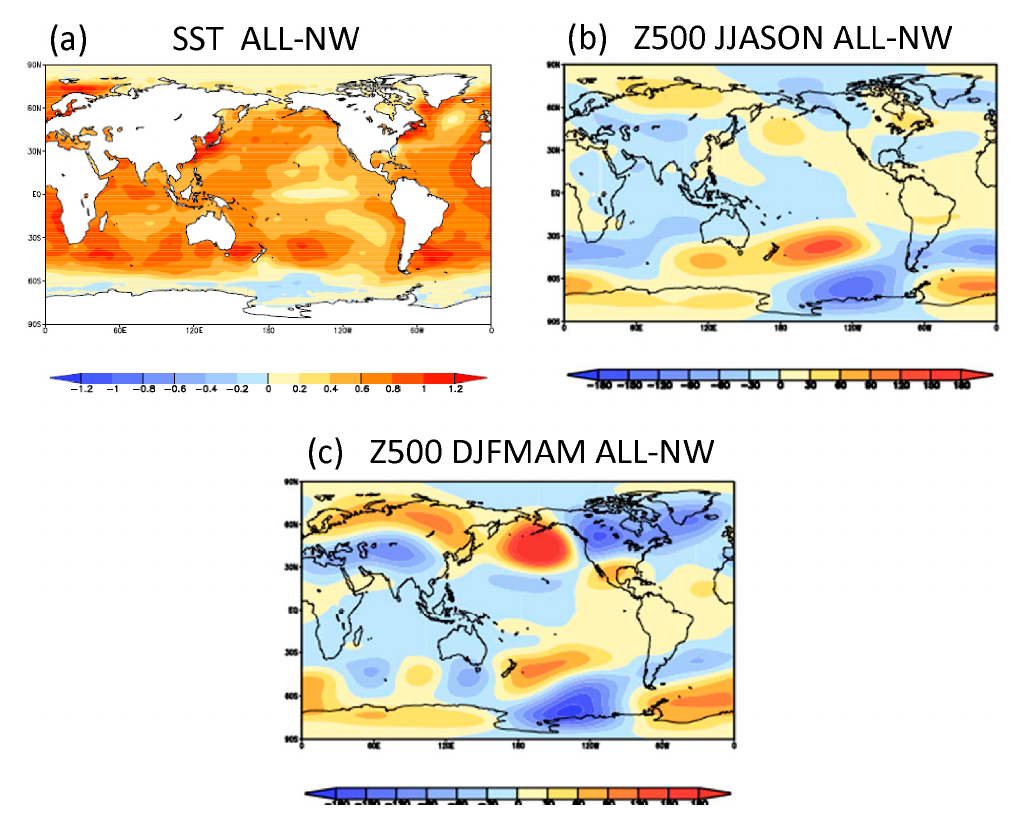
Figure 8. Differences between the ALL and NW run averaged from 1981 to 2010 (ALL minus NW). ( a ) Annual SST (K); ( b ) Z500 [m] for JJASON; ( c ) Z500 (m) for DJFMAM. A 100-member mean is used.